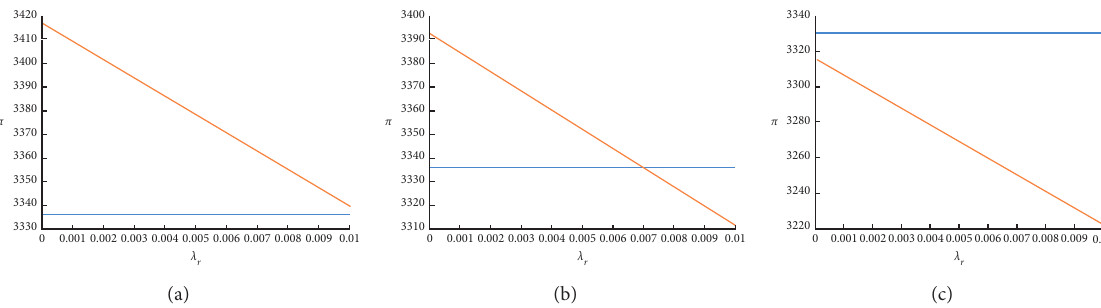
Figure 5: The relationship between the time dependence λ